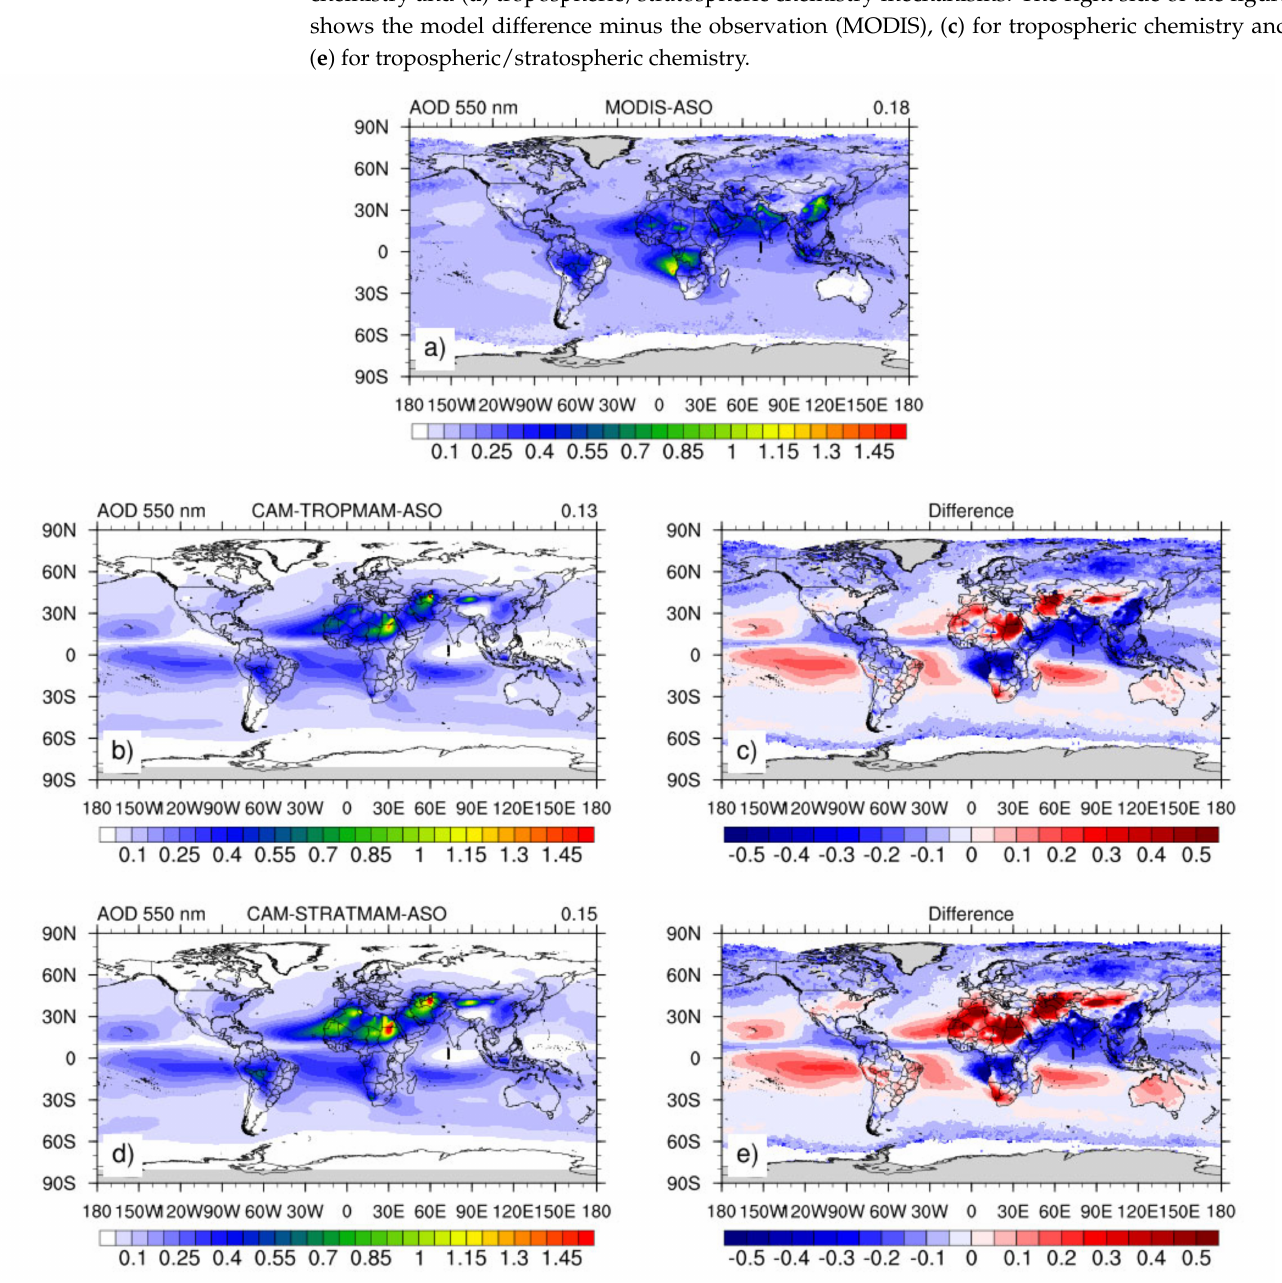
Figure 10. ( a ) AOD observed by MODIS sensor for August-September-October (ASO), in the period of 2010–2014, ( b ) AOD simulated by the CAM5-MAM3 model using tropospheric chemistry and ( d ) tropospheric/stratospheric chemistry mech- anisms. The right side of the figure shows the model difference minus the observation (MODIS), ( c ) for tropospheric chemistry and ( e ) for tropospheric/stratospheric